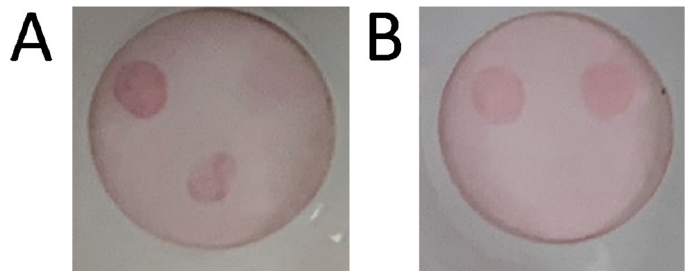
Figure 4. VFA for SARS-CoV-2 N detection using E2-RZ coated AuNPs. Both Miriad test cartridges were spotted with bivalent C2-B6 sdAb near the bottom, goat anti-VHH top left, and NeutrAvidin top right. After each cartridge was challenged with 100 µL of N at 3 µg/mL, 100 µL of E2-RZ-Bt- Ovalbumin-AuNP (panel ( A )) or 100 µL of E2-RZ-Bt-caseine (panel ( B )) was applied to generate the colored spot.